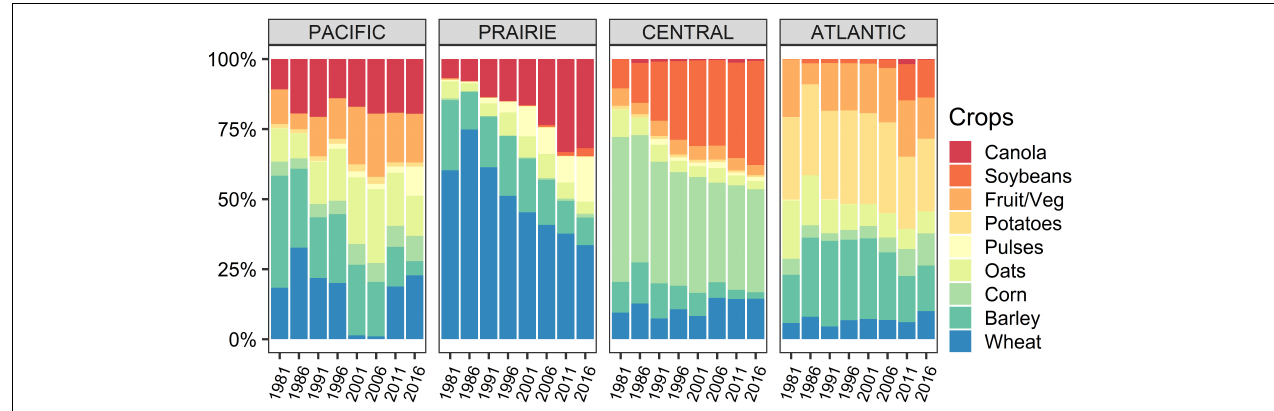
FIGURE 3 | Proportion of land planted with nine major agricultural crops for eight census years (1981–2016) for each of the four agricultural regions in Canada. The agricultural regions are ordered from west to east: British Columbia (Pacific), Alberta, Saskatchewan and Manitoba (Prairie), Ontario and Quebec (Central), and Nova Scotia, New Brunswick, Newfoundland/Labrador, Prince Edward Island